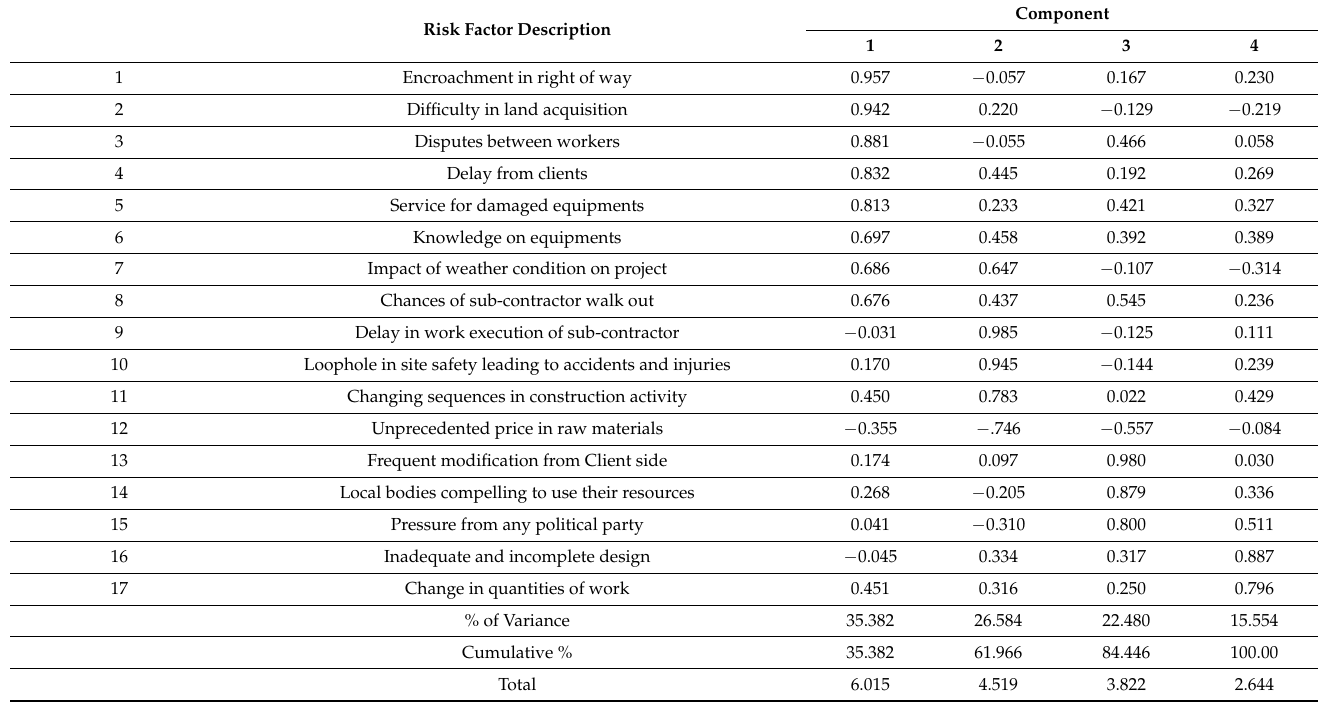
Table 2. Total variance is explained here by different